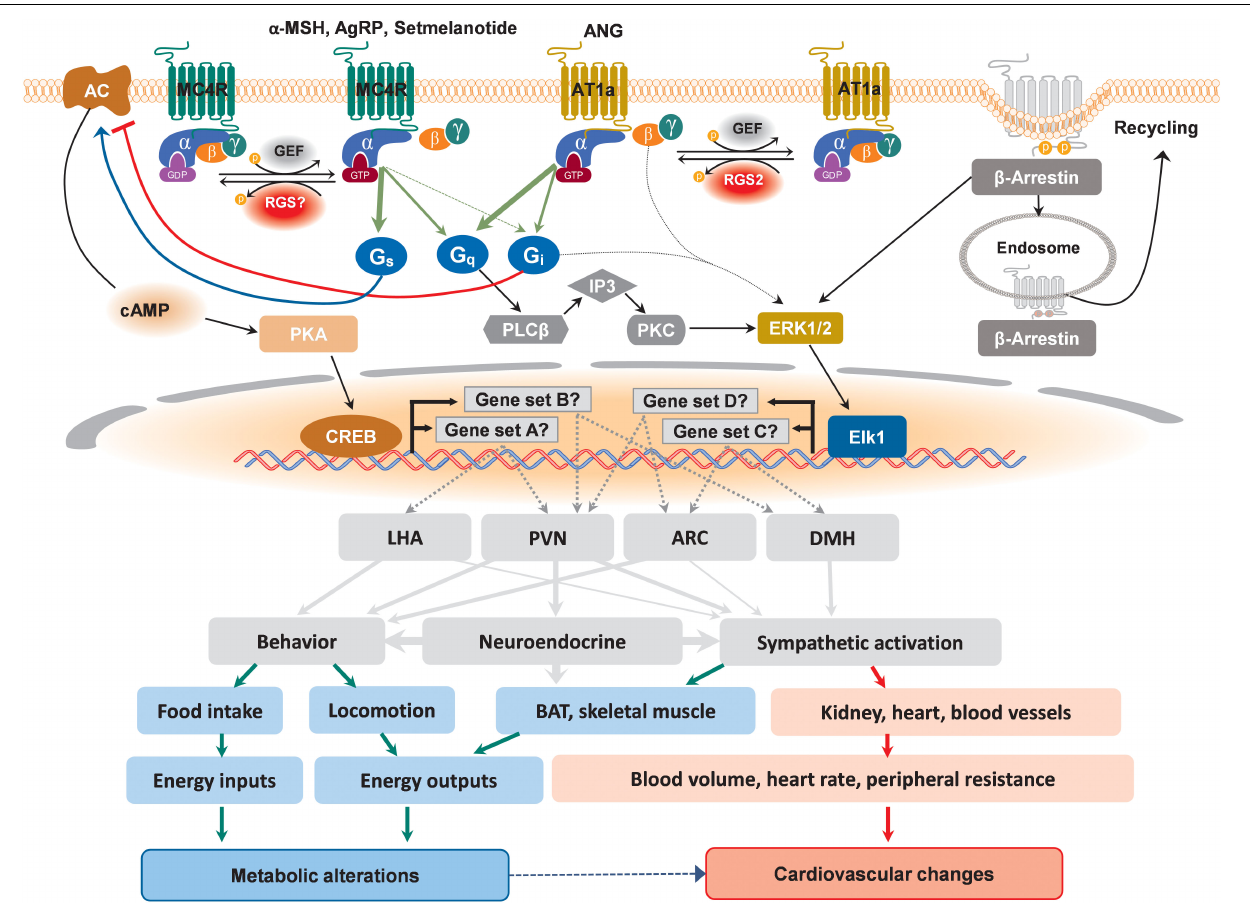
FIGURE 1 | Schematic depicting possible divergent signaling cascades downstream of MC4R and AT1a in distinct hypothalamic nuclei that might differentially affect metabolic and cardiovascular regulations. Upon binding to its designated ligands, MC4R activates canonical G α s -AC-cAMP-PKA-CREB pathway, leading to the transcription of genes in different hypothalamic nuclei. Additionally, the activation of non-cannonical signaling pathways involving G α q and G α i has also been reported for MC4R, which lead to the activation of ERK-Elk1 transcriptional axis to drive the expression of different sets of responsive genes in different hypothalamic nuclei. Differential recruitment of these divergent signaling pathways may defines ultimate physiological changes. For AT1a, although reported canonical pathway is G α q -mediated activation of ERK, a possible non-canonical coupling to G α i has also been supported experimentally, which, depending on the action of site, may lead to differential metabolic and cardiovascular outcomes. In addition to well-known receptor internalization for subsequent recycling or degradation, β -Arrestin-mediated activation of ERK transduction has also been reported for both MC4R and AT1a. These multilevel selectivities of GPCR signaling pathways ranging from intracellular molecular events to the brain regions of action and the effective organs could all lead to different metabolic alterations and cardiovascular